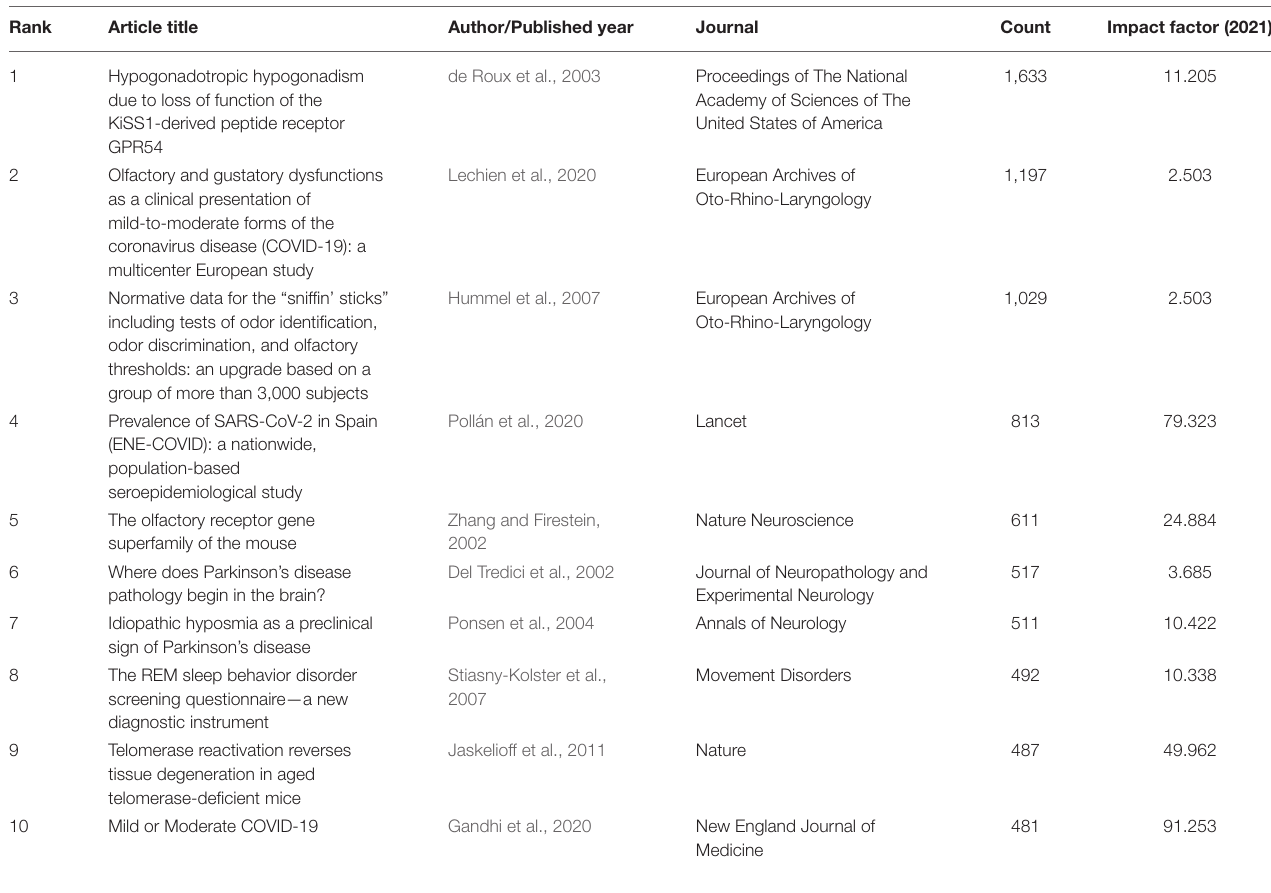
TABLE 5 | Top 10 co-cited references in the field of olfactory dysfunction from 2002 to